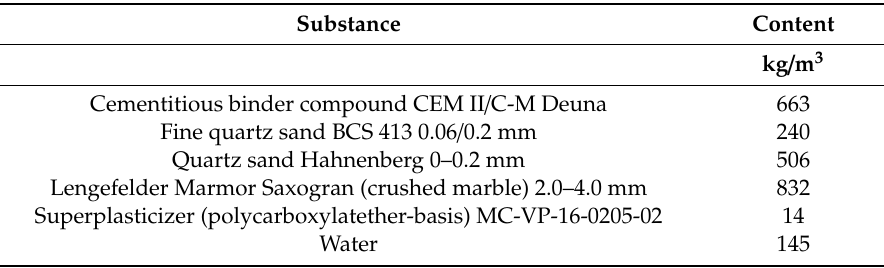
Table 3. Mix design of concrete